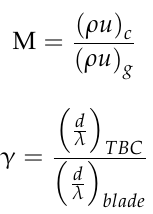
Figure 4. ( a , b ) Distribution of ∆ T 1 and ∆ T 2 at different BR under h 2 = 10,000W/ (cid:4666) m (cid:2870) ∙ K (cid:4667) , γ (cid:3404) 9 . In order to verify Equation (5), it is necessary to calculate the temperature ‐ drop of the coating itself ( ∆𝑇 (cid:2869) ) and the temperature ‐ drop difference between the external surface of the metal blade with or without coating ( ∆𝑇 (cid:2870) ) at x/D = 30 under different conditions. Table 2 and Figure 5 shows the comparison of the calculated and theoretical results, in which the temperature ‐ drop ratio ∆𝑇 (cid:2869) / ∆𝑇 (cid:2870) matches well under different BR and h 2 . How ‐ ever, there is a difference in value between the calculated results and theoretical results, which is because the computational model is not an ideal 1 ‐ D heat transfer model; thus, heat transferring is in a mainstream direction between the coolant gas in the film ‐ hole with TBC and the metal part. In summary, Equation (5) verifies that variation law is basi ‐ cally the same as the temperature ‐ drop of the coating itself ( ∆𝑇 (cid:2869) ) and the temperature ‐ drop difference between the external surface of the metal blade with or without coating ( ∆𝑇 (cid:2870) ). Table 2. Computational and theoretical data of ∆𝑇 (cid:2869) / ∆𝑇 (cid:2870) under different conditions. Case(x/D = 30)